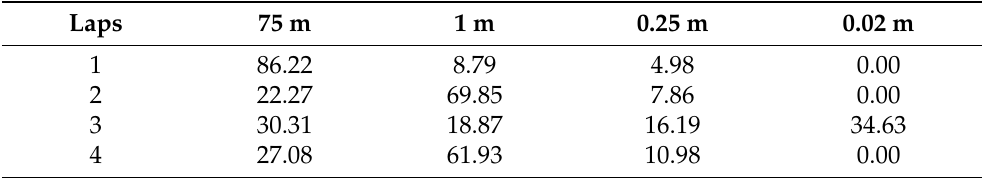
Table 1. Percentage ratio of data samples and the corresponding expected accuracy during the laps with RTK position augmentation through the Burgholz tunnel.